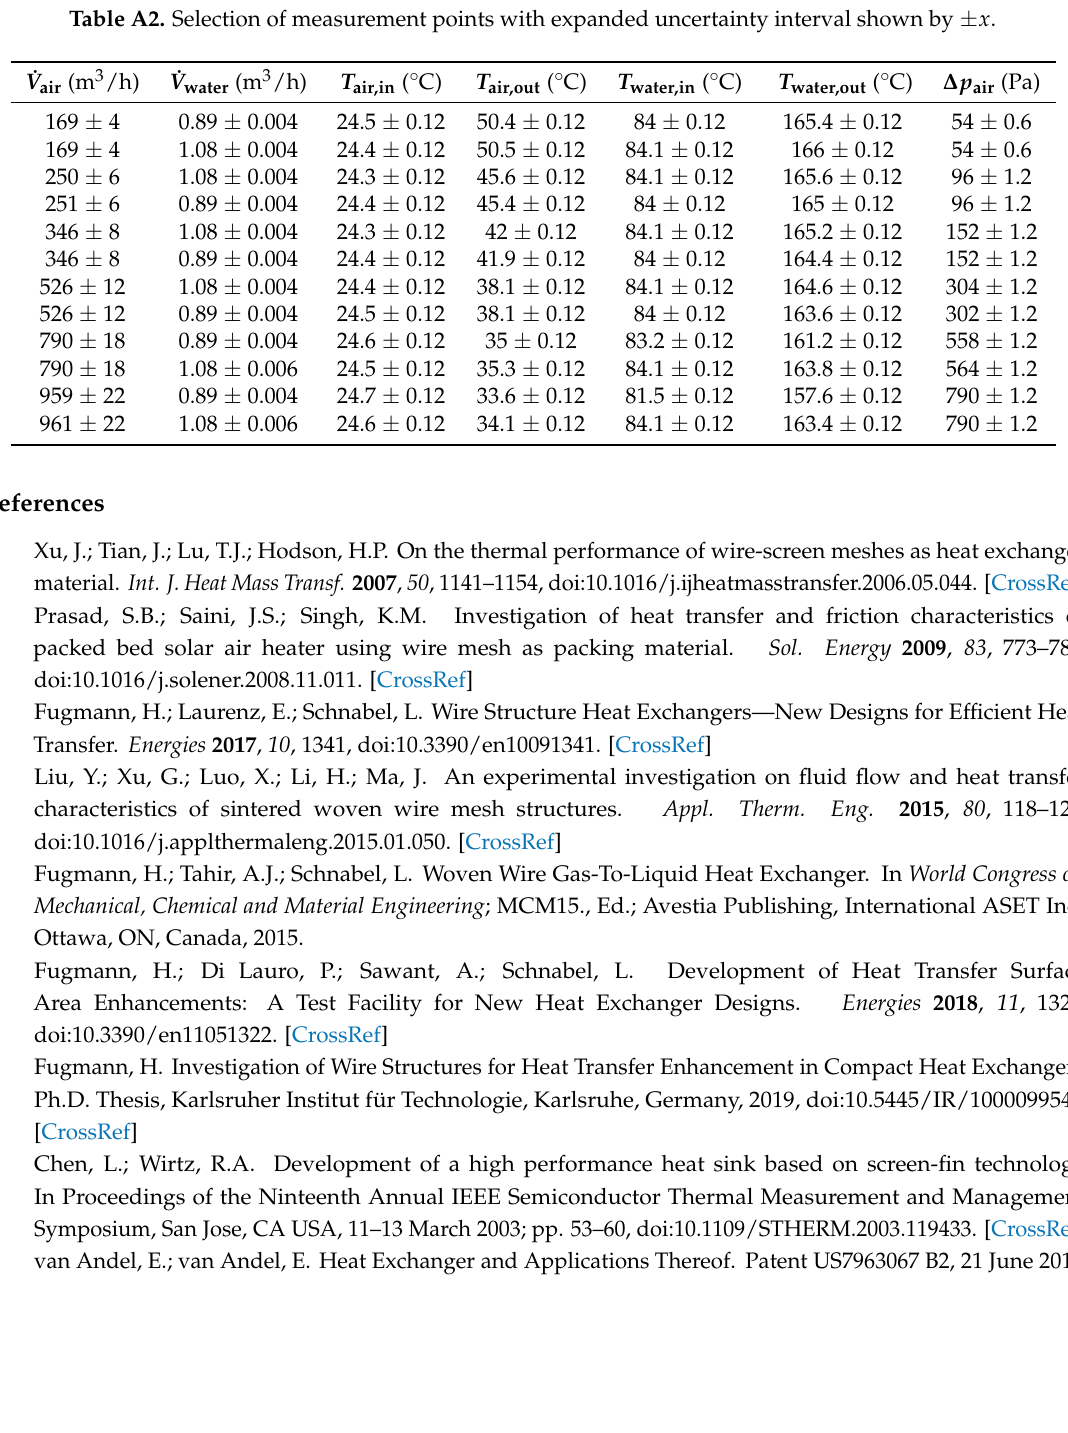
Table A2. Selection of measurement points with expanded uncertainty interval shown by